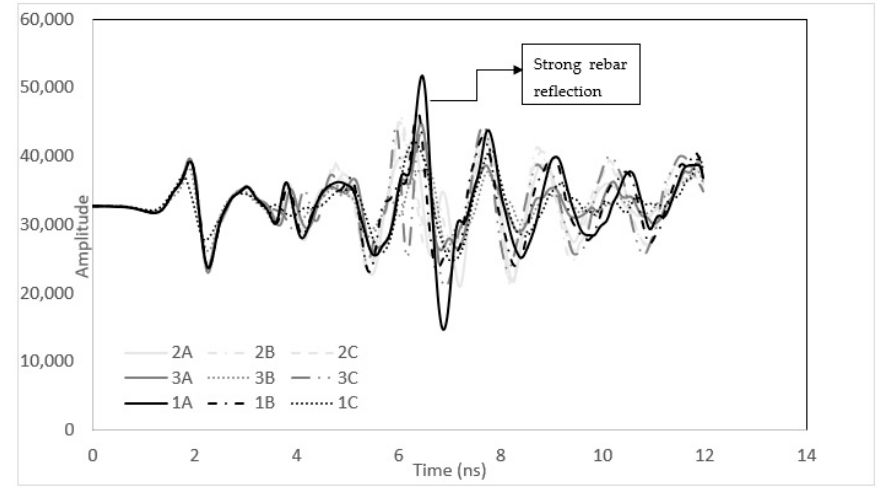
Figure 18. Plot showing signals for sound portions and corroded rebar regions.